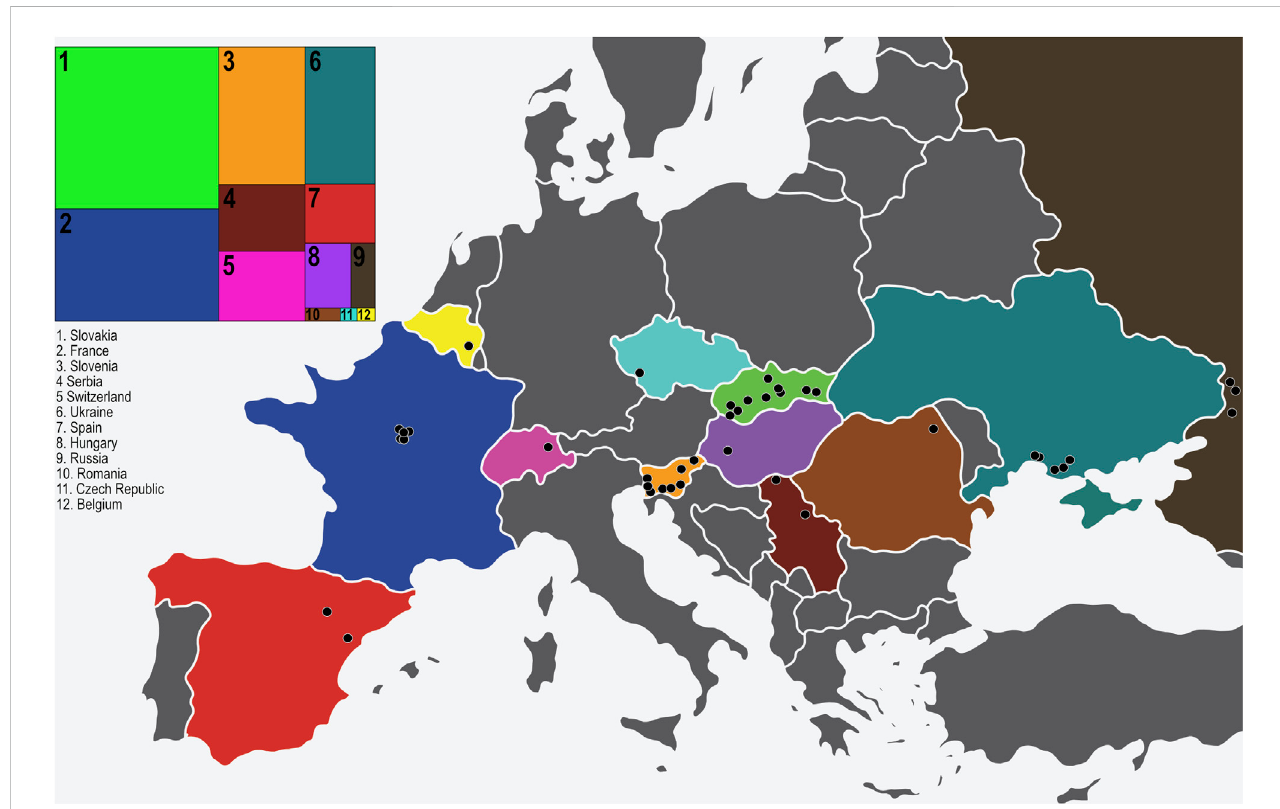
FIGURE 1 The40samplinglocationsof D.pini inEurope.Theinserttotheleftindicatestheproportionofisolatesobtainedpercountryinrelationtoothercountries (numbered from 1 – 12). The countries are colour coded on the map to match the insert (original map obtained from https://www.vecteezy.com/free-vector/ europe-map) and each sampling location is indicated with a black